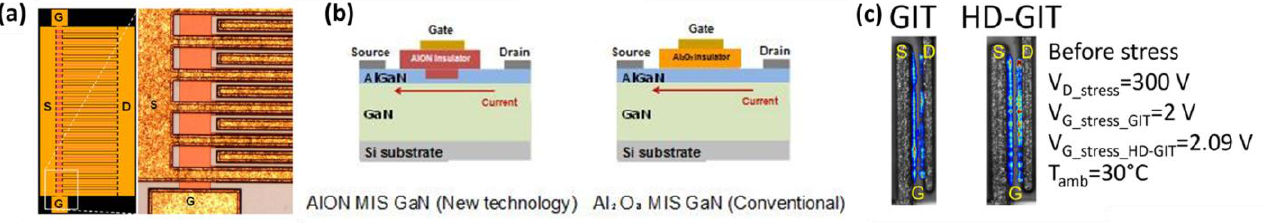
Figure 9. ( a ) Layout (left) and microscope picture detail (right) of a 60 mm gate width power device. ( b ) AlON MIS GaN (new tech.), and Al 2 O = MIS GaN (conventional). ( c ) A false color profile is taken after the application of V D = 300 V, V G _GIT = 2 V, and V G _HD-GIT = 2.09 V. Under semi-ON conditions, the luminescence is localized at the drain side of the gate and at the drain contact both in the GIT and in the HD-GIT [66,162,164]. Figure reproduced with permission from IEEE Proceedings.